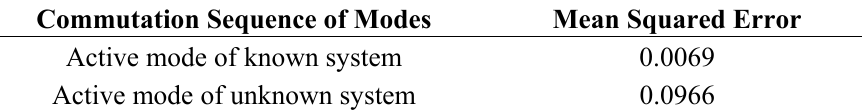
Table 1. Output error of piecewise linear